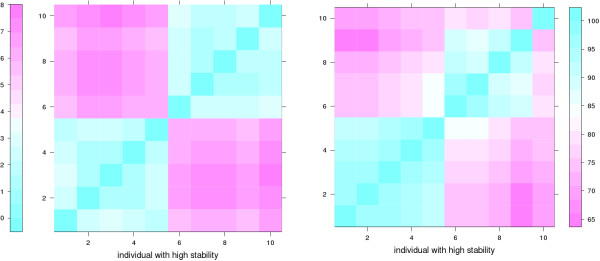
Pairwise comparison of stable individuals. Pairwise comparison of all sequences with highest stability (σ = 1) and wild-type VH (individual 6) with respect to structure (left) and sequence (right). The left panel shows the pairwise RMSD with respect to Cα-positions after optimal superposition; color codes RMSD in units of 1 Å (= 0.1 nm). The right panel gives the percentage sequence identity between the same peptides as on the left (using same numbering of individuals as there). The figure shows that the individuals fall into two clusters or sub-folds, a cluster with modified fold and sequences (individuals 1–5) and a cluster similar to the wild-type (individuals 6–10).